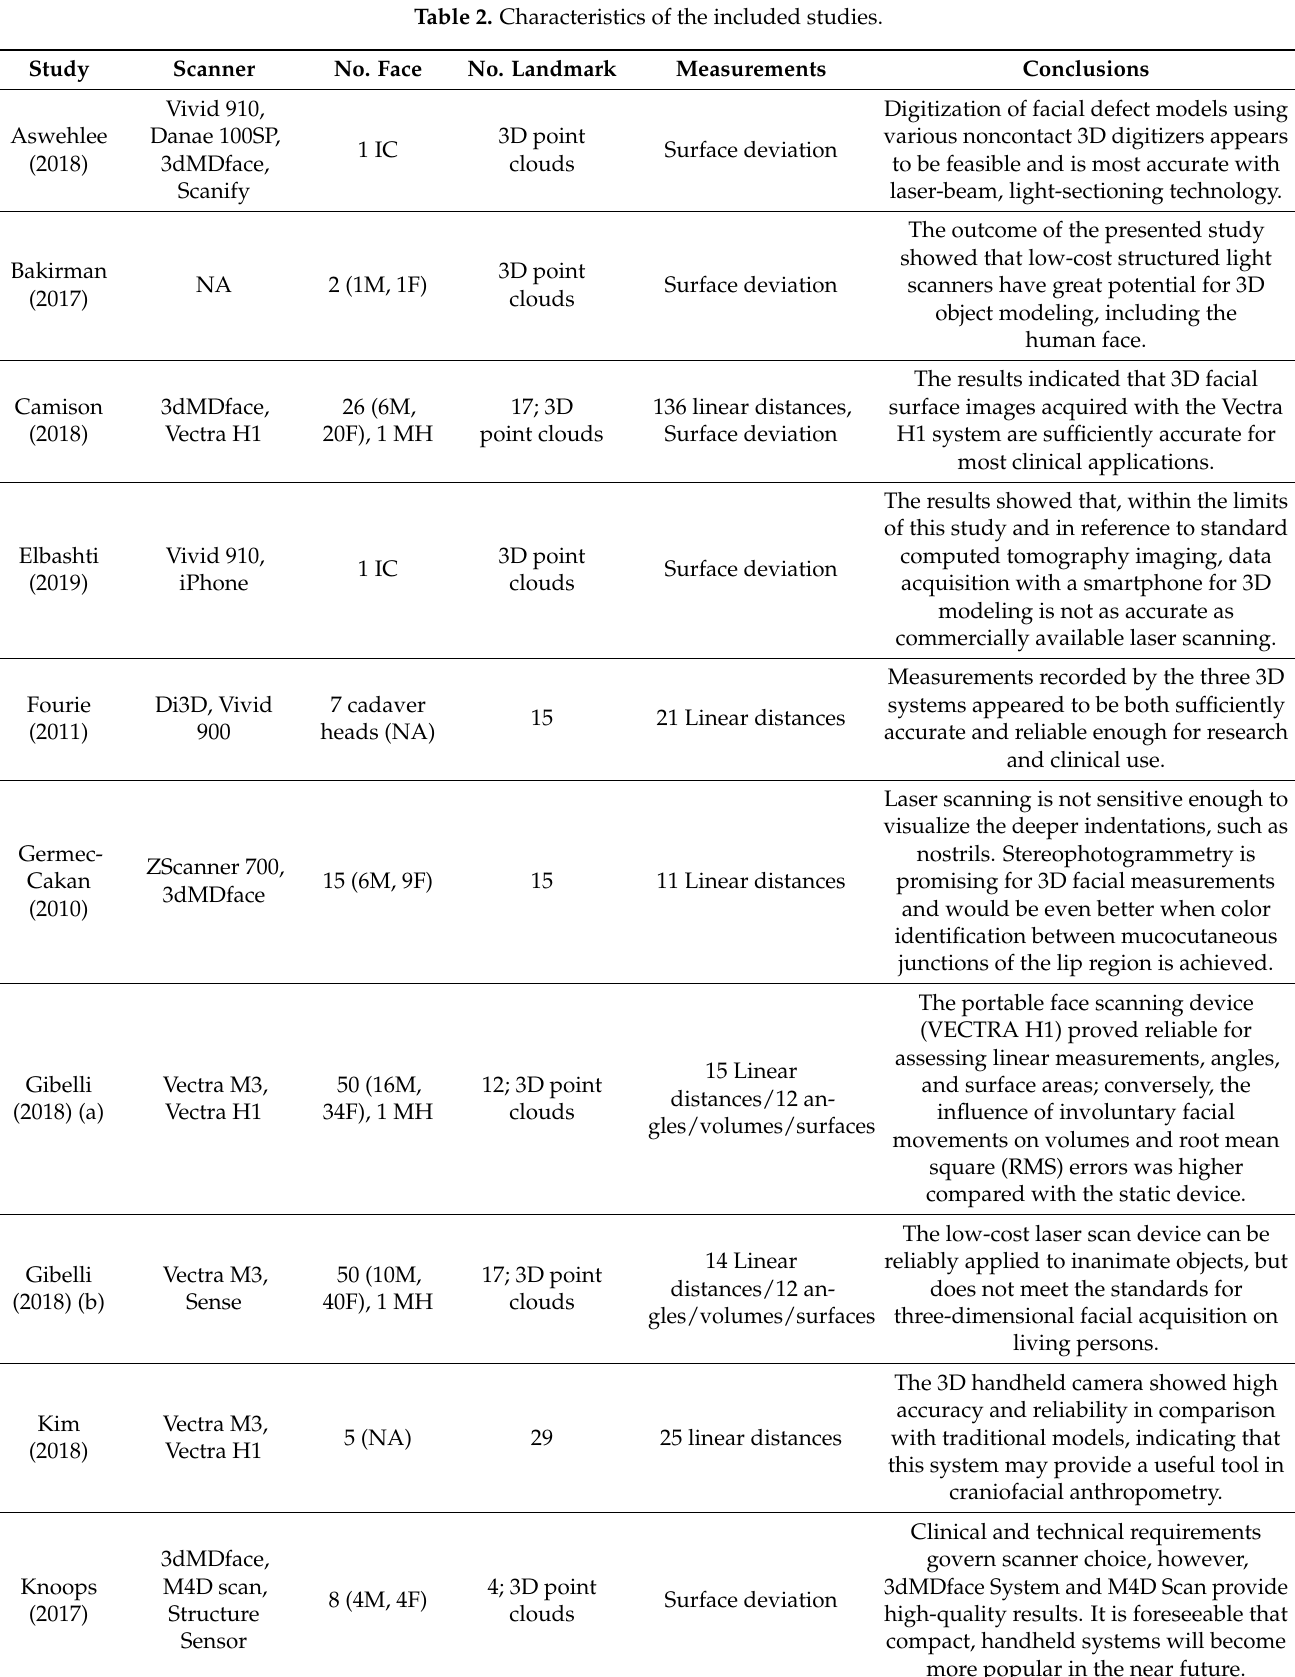
Table 2. Characteristics of the included